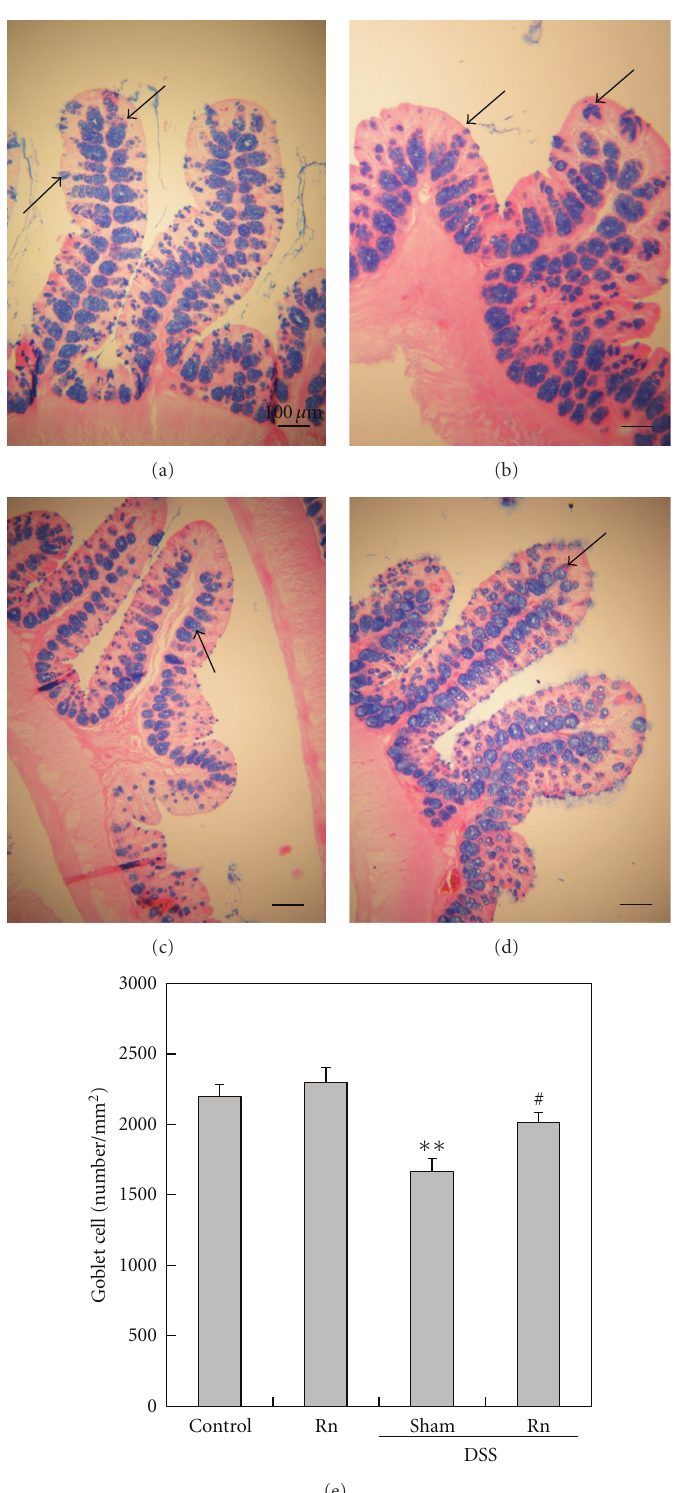
Figure 3: Loss of goblet cells in the colon after colitis induction. (a) Control, (b) radon inhalation only, (c) sham inhalation with DSS administration, and (d) radon inhalation with DSS administration. All samples were stained with alcian blue. Arrow indicates alcian blue- positive goblet cells. Scale bar is 100 μ m ( × 100). (e) Larger number of goblet cells in mice treated with radon inhalation than in mice treated with sham inhalation. Each value is the mean ± SEM. The number of mice for each experiment and significance are the same as in Figure